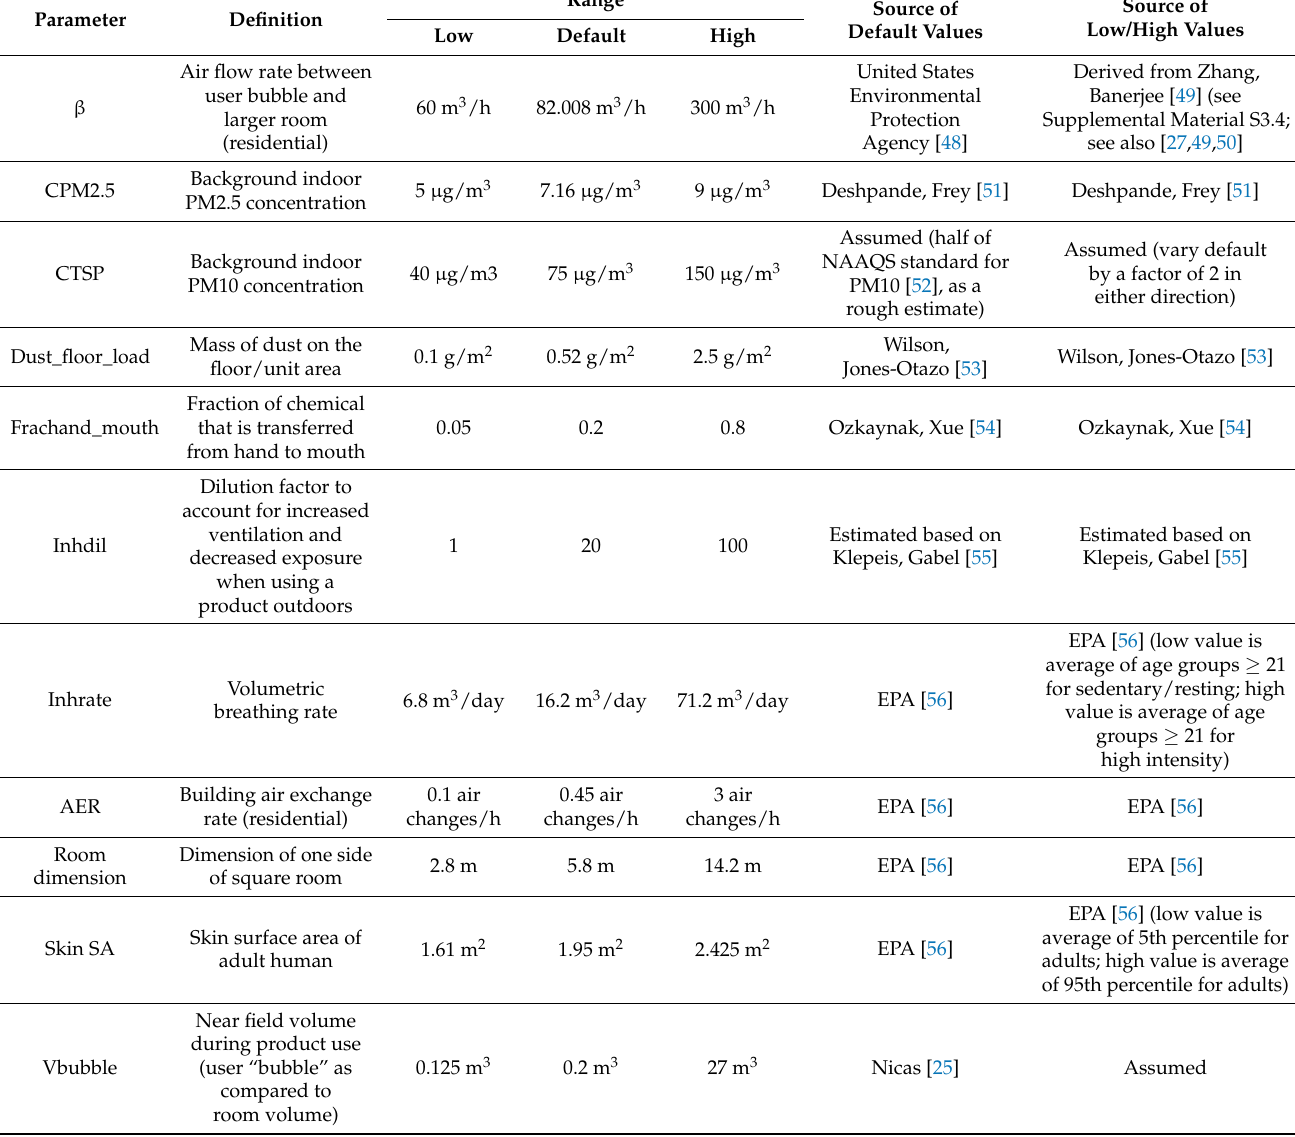
Table 1. Parameters selected to conduct one-way sensitivity